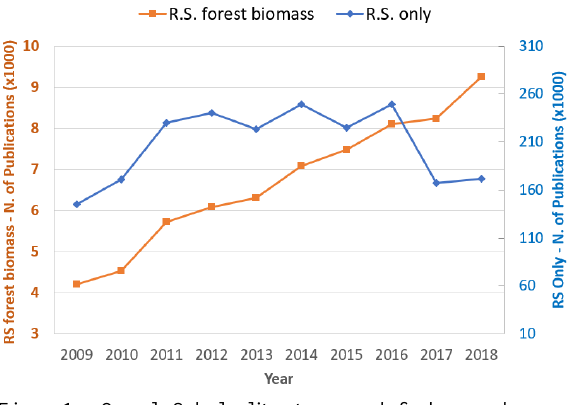
Figure 1. Google Scholar literature search for keywords “forest volume and biomass estimation using remote sensing” (orange) and “remote sensing” only